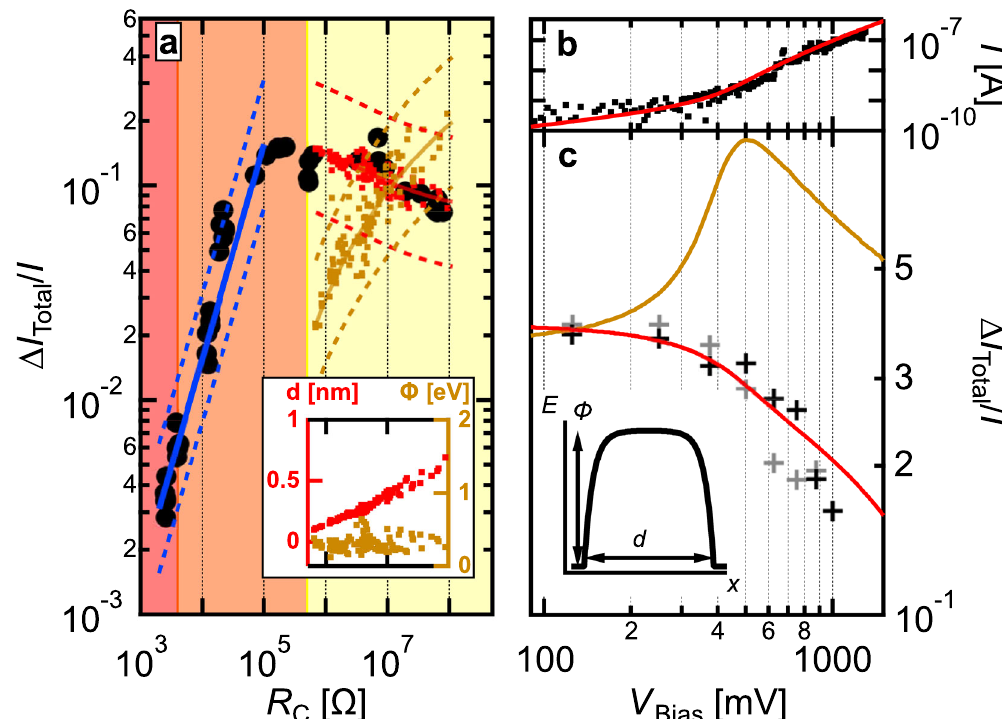
Fig. 4 Model analysis of single-device noise characteristics. a Relative current fl uctuation as a function of the constriction resistance ( R C ) recorded during the EB process of a speci fi c graphene bow-tie device (black dots). The blue line shows the best fi t to the data in the orange nanojunction regime assuming width ( W ) fl uctuations. The dashed lines represent doubled/halved Δ W fl uctuations compared to the best- fi tting value of Δ W = 0.27 nm. The red and brown dots represent the best fi t to the data in the yellow nanogap regime considering purely d or purely Φ fl uctuations, and relying on the actual d and Φ values obtained from the Simmons fi tting for each junction. The brown and red lines represent the best fi tting resistance dependence of Δ I / I relying on the averaged Φ = 0.31 eV barrier height for all junctions. The red and brown dashed lines refer to the calculated noise levels using a doubled/halved ΔΦ and Δ d fl uctuations compared to these best- fi tting curves. The inset shows the fi tted tunnel barrier heights (brown) and lengths (red) as a function of the resistance. b Current – voltage characteristic of a graphene nanogap junction (black dots) and it is fi tting by the numerically evaluated Simmons model (red line). c Relative current fl uctuation as a function of the bias voltage measured right after the I ( V ) measurement on b . The black and gray crosses respectively correspond to the upward and the subsequent downward voltage sweep demonstrating the stability of the junction along the entire 32 s length of the voltage- dependent noise measurement. Δ I / I starts to decrease at the bias close to the barrier height ( Φ = 0.35 eV). The red and brown lines represent the calculated voltage dependence of the relative current fl uctuation relying on purely d and Φ fl uctuations, respectively. The inset shows the schematic of the potential barrier used for the numerical evaluation of the Simmons